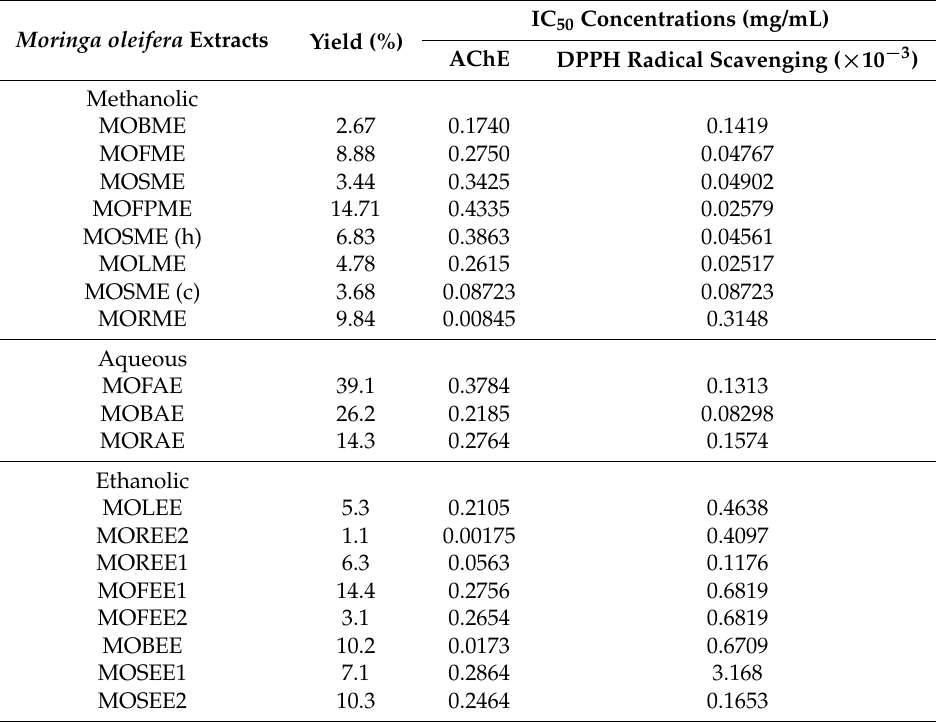
Table 1. Percentage yield, AChE inhibitory, and 2,2-Diphenyl-1-picrylhydrazyl (DPPH) radical scavenging potency of Moringa oleifera methanolic, aqueous and ethanolic extracts.